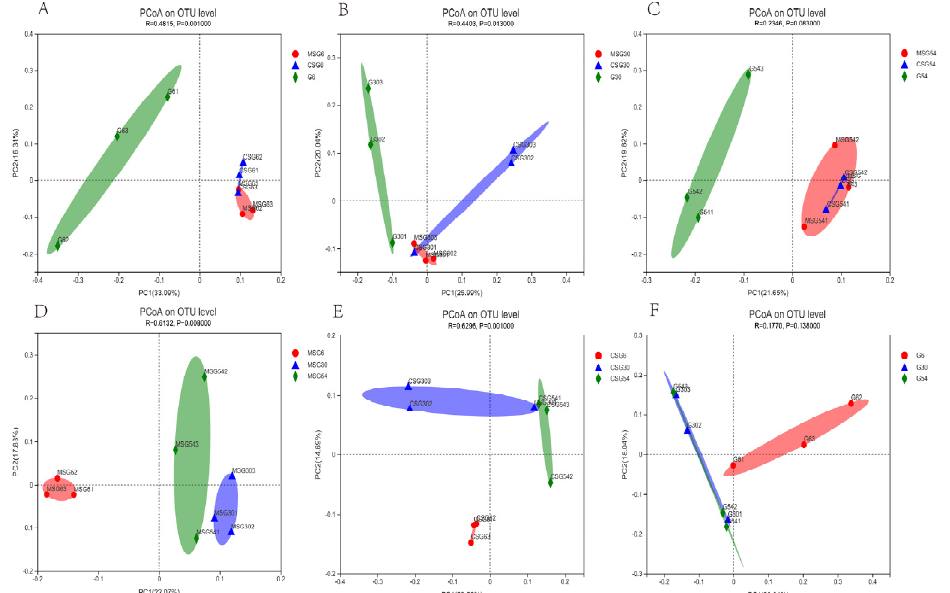
Figure 2. PCoA plots using Bray − Curtis dissimilarity based on ASVs of rumen microbiota in yaks.